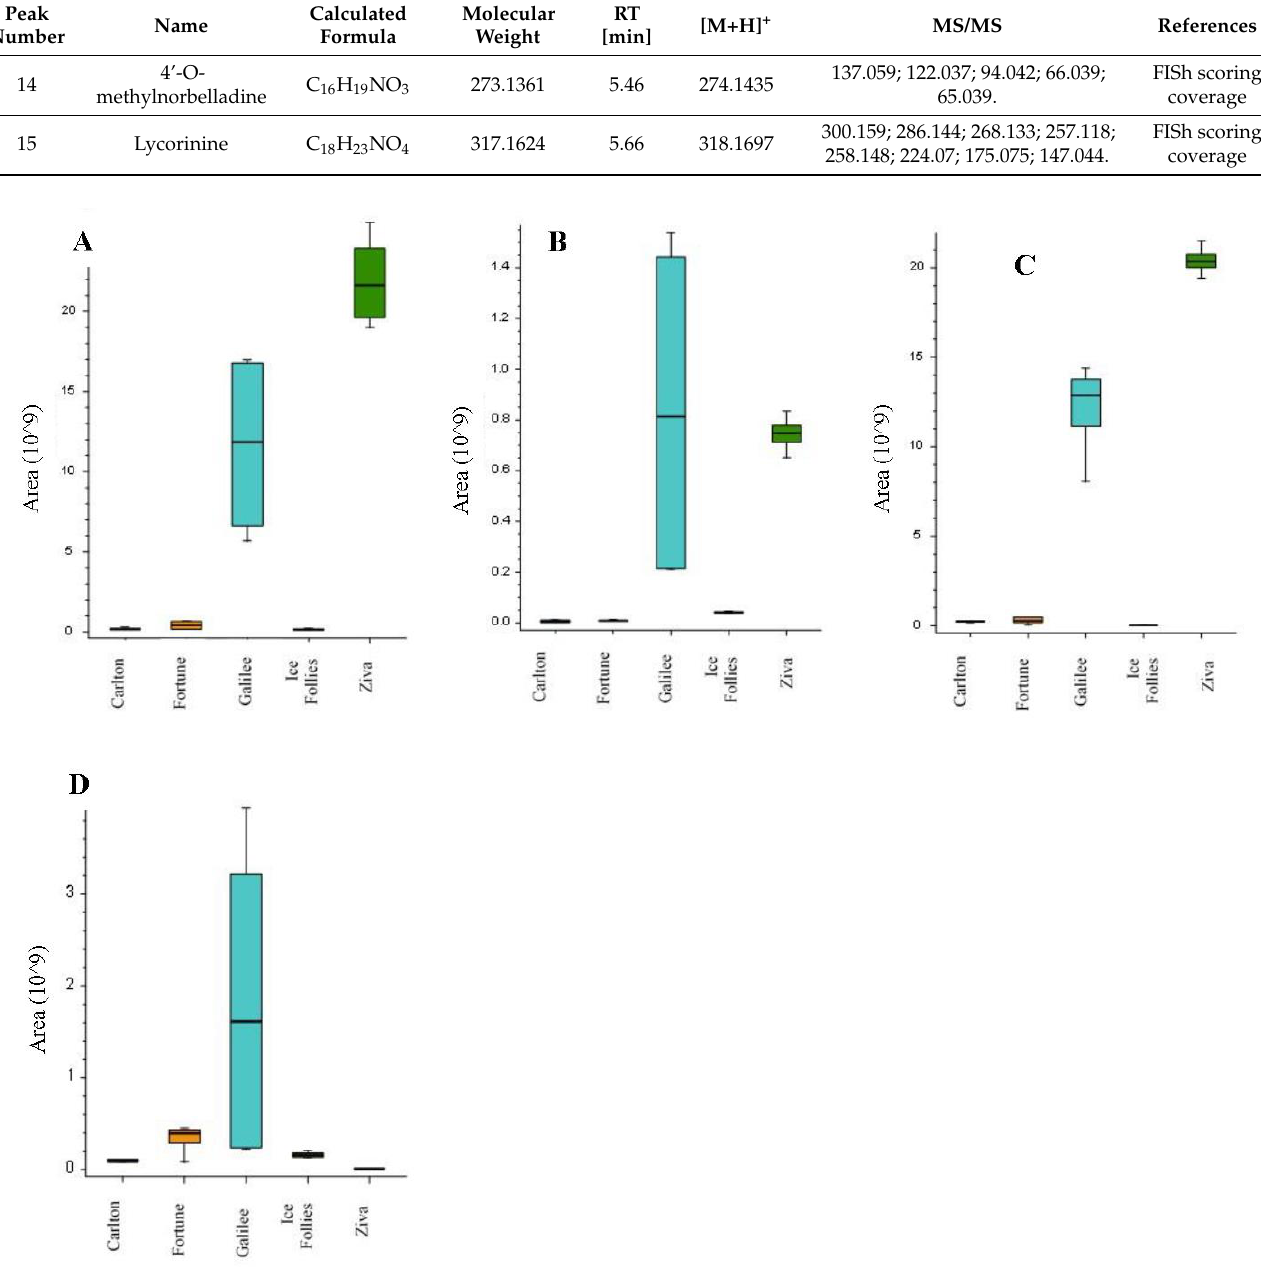
Figure 3. The distribution of the compounds lycorine ( A ), latifaliumin A ( B ), lycorinine ( C ) and tazettine ( D ) detected mainly in the Galilee and Ziva cultivars presented as box plots. The figures present the mean area values obtained from four extracts for each cultivar ( n = 4), where the limit of the lower and upper quartile and minimum and maximum of the distribution are presented as error bars.